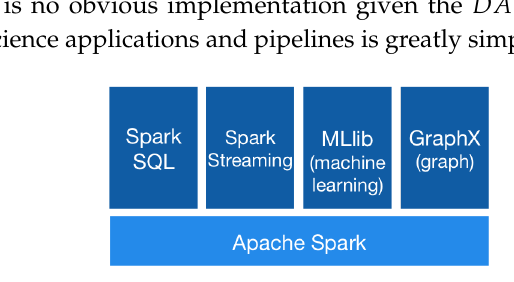
Figure 3. Apache Spark API